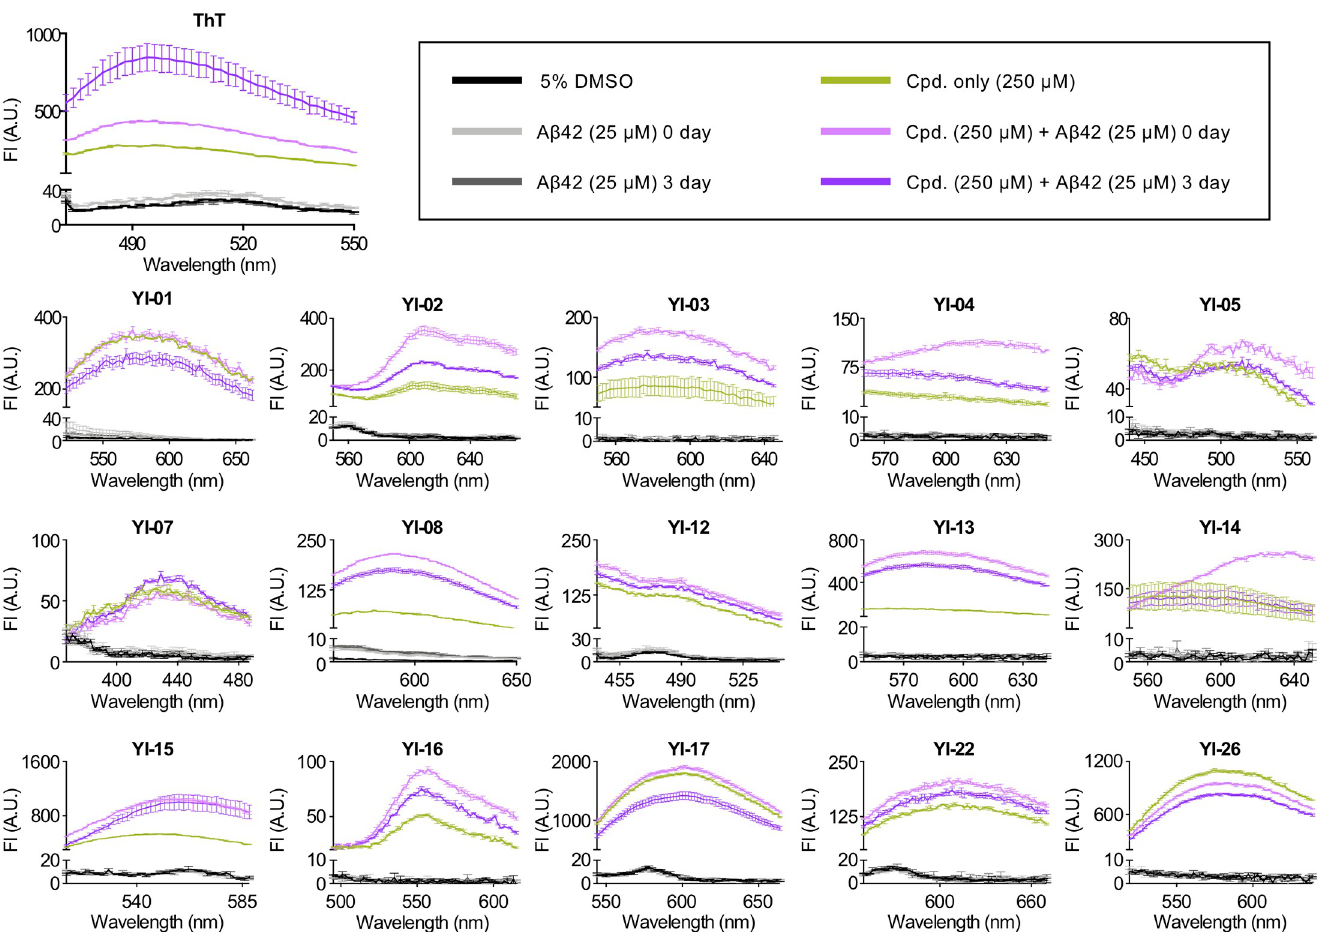
Fig 3. Fluorescence spectra of YI compounds in the presence of A β 42. Selected 15 YI compounds (250 μ M) were added to 25 μ M A β 42 monomers or aggregates obtained by 3-day incubation. Emission spectra of YI compounds with A β 42 in 3:1 ratio were recorded with the individual excitation wavelength as following: YI-01 , 362 nm; YI-02 , 472 nm; YI-03 , 330 nm; YI-04 , 412 nm; YI-05 , 320 nm; YI-07 , 332 nm; YI-08 , 310 nm; YI-12 , 410 nm; YI-13 , 394 nm; YI-14 , 440 nm; YI-15 , 475 nm; YI-16 , 330 nm; YI-17 , 486 nm; YI-22 , 480 nm; YI-26 , 415 nm. Fluorescent intensity of ThT (5 μ M) in the presence of A β 42 monomers or aggregates (25 μ M) was measured as a control. Spectra of all samples were acquired using an Infinite 200 PRO plate reader. Abbreviations: Cpd. = compound, FI = fluorescence intensity, AU = arbitrary unit.